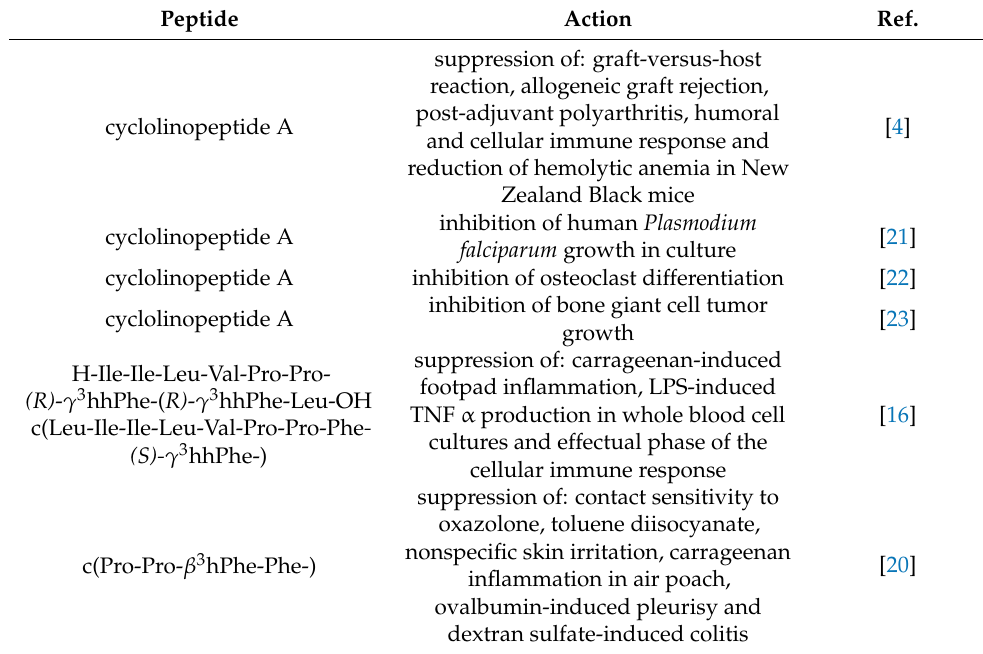
Table 1. The immunological activities of cyclolinopeptide A and its